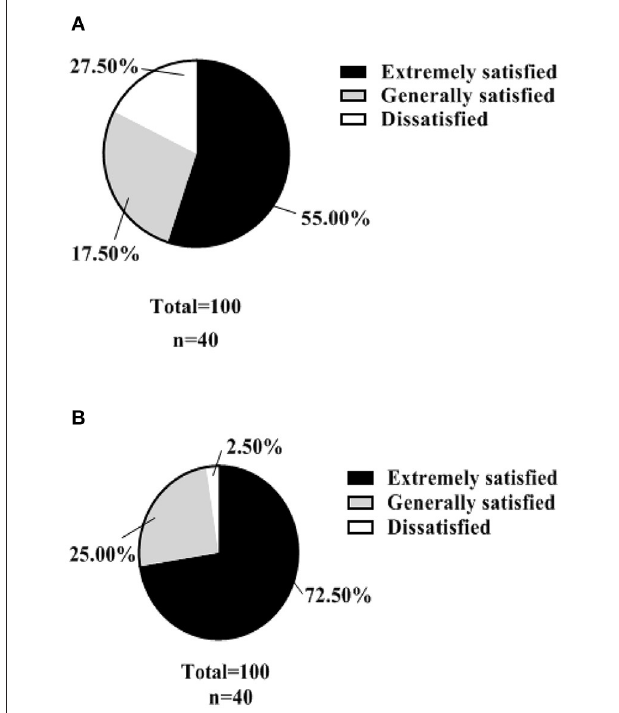
FIGURE 5 | Nursing satisfaction ( n , %). (A) shows the satisfaction rate of patients in the control group with the management of their care. (B) shows the satisfaction rate of patients in the test group with the nursing